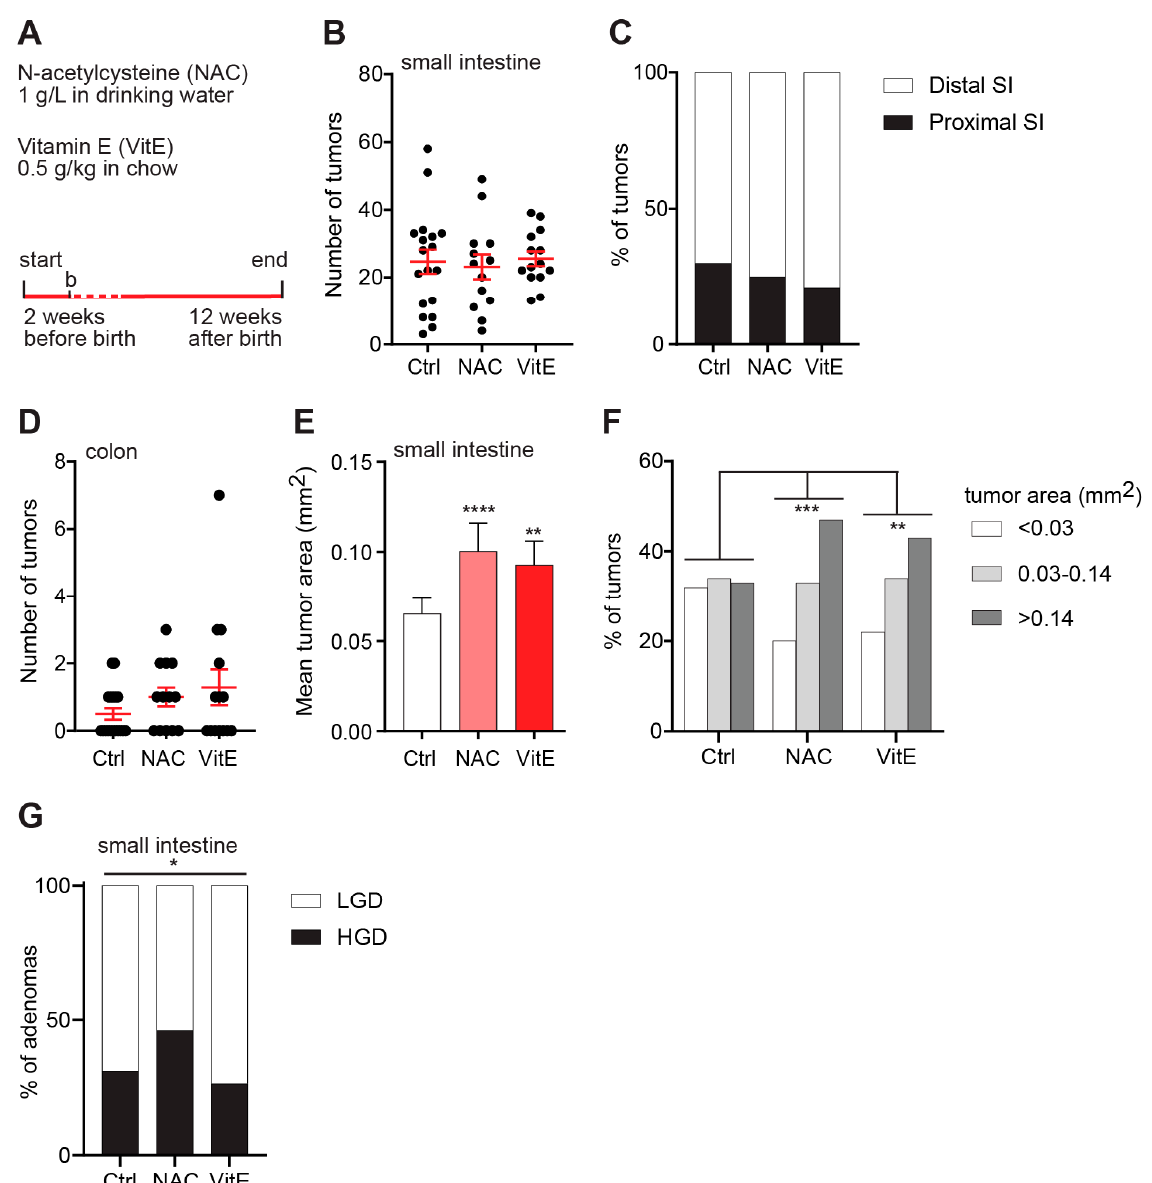
Figure 2. NAC or vitamin-E treatment increases the size of early tumors. ( A ) Schematic of the study design. Two structurally unrelated dietary antioxidants, NAC and VitE, were supplemented in the drinking water or chow diet of pregnant dams from two weeks before birth until weaning and, thereafter, to the pups until 12 weeks of age. Dashed line indicates breast feeding period. ( B , C ) Tumor numbers in one sagittal section of the small intestine ( B ) and the distribution of tumors between the proximal and distal parts of the small intestine ( C ) of 12-week-old APC Min/+ mice ( n = 18 Ctrl, 13 NAC, 14 VitE). ( D ) Number of colonic tumors in 12-week-old APC Min/+ mice ( n = 18 Ctrl, 13 NAC, 14 VitE). ( E , F ) The geometric mean area ( E ) and size distribution ( F ) of tumors in the small intestines of 12-week-old APC Min/+ mice ( n = 303-427 tumors, error bars indicate 95% confidence intervals). ( G ) Distribution graph showing the percentage of adenomas with HGD or LGD in the small intestines of 12-week-old APC Min/+ mice ( n = 74-102 adenomas per group). HGD, high-grade dysplasia; LGD, low-grade dysplasia. * p < 0.05, ** p < 0.01, *** p < 0.001, and **** p < 0.0001.